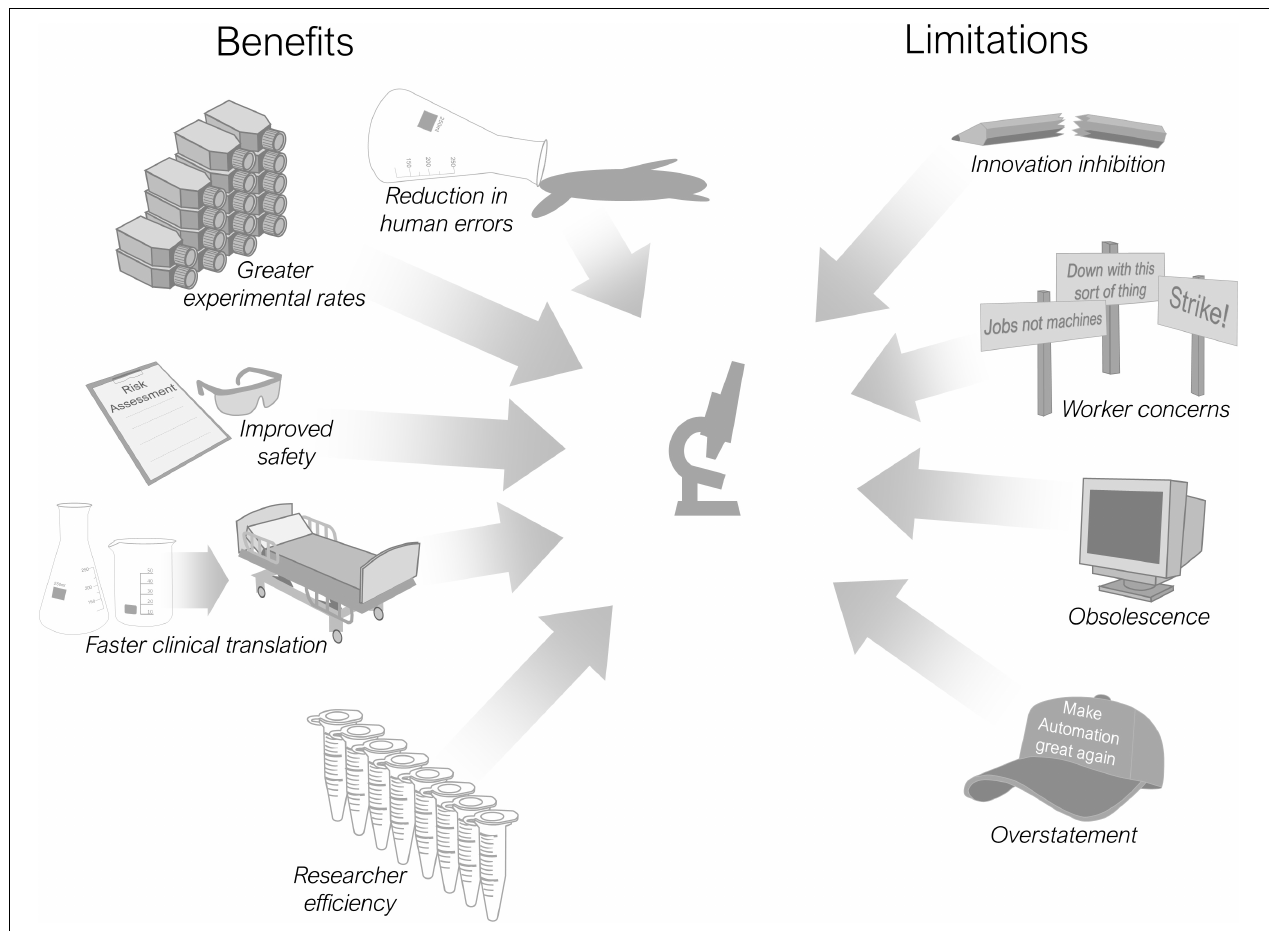
FIGURE 2 | Benefits and limitations of research laboratory